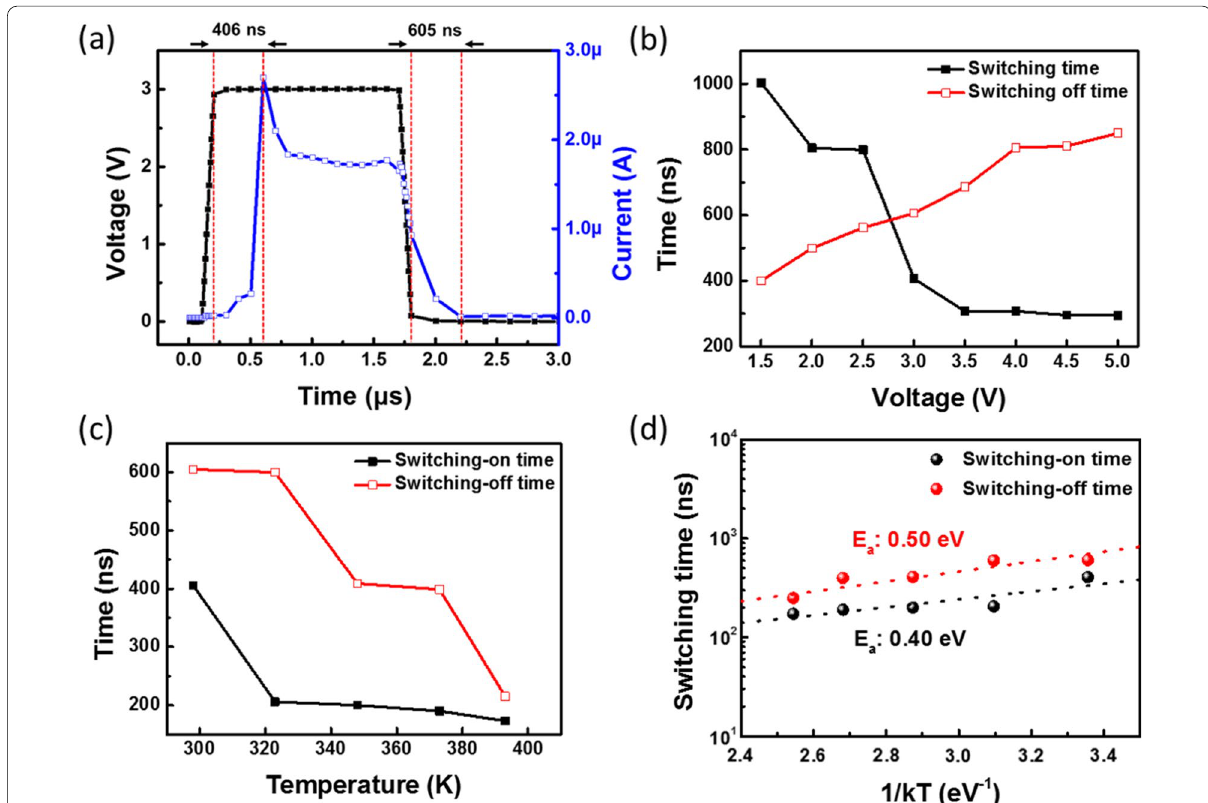
Fig. 5 a AC I – V measurement of the Ag-Ga 2 Te 3 selector device (measurement conditions: rising time time